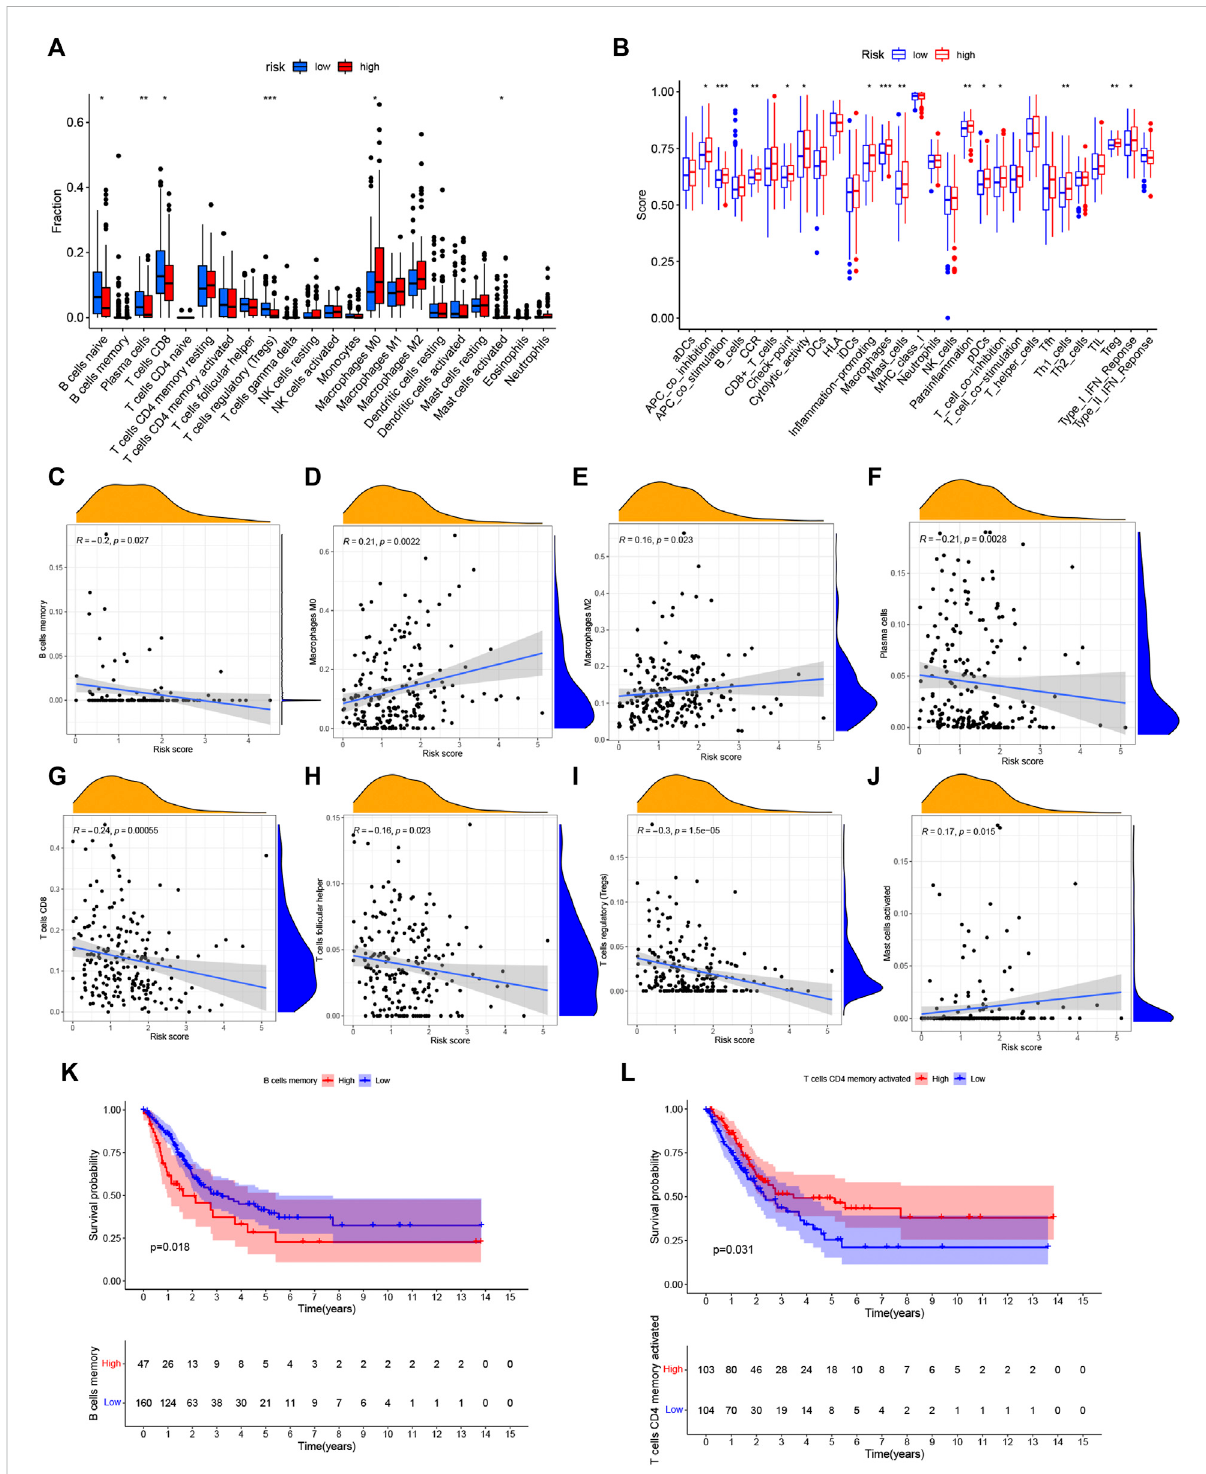
FIGURE 8 Analysis of immune activity. (A) Comparison of immune cells. And 6 of these immune cell types were differentially expressed in two risk groups ( p < 0.05). (B) Comparison of immune-correlated pathways. The high-risk group of the TCGA cohort signi fi cantly had a higher score than the low- risk group. (C – J) : There was a positive correlation between the survival outcome of BC patients and the high degrees of Macrophages (M0, M2) and Mast cells, while there was a negative correlation of CD8 T cells, B cells, T cells follicular helper, Tregs and plasma cells (K,L) : Kaplan –